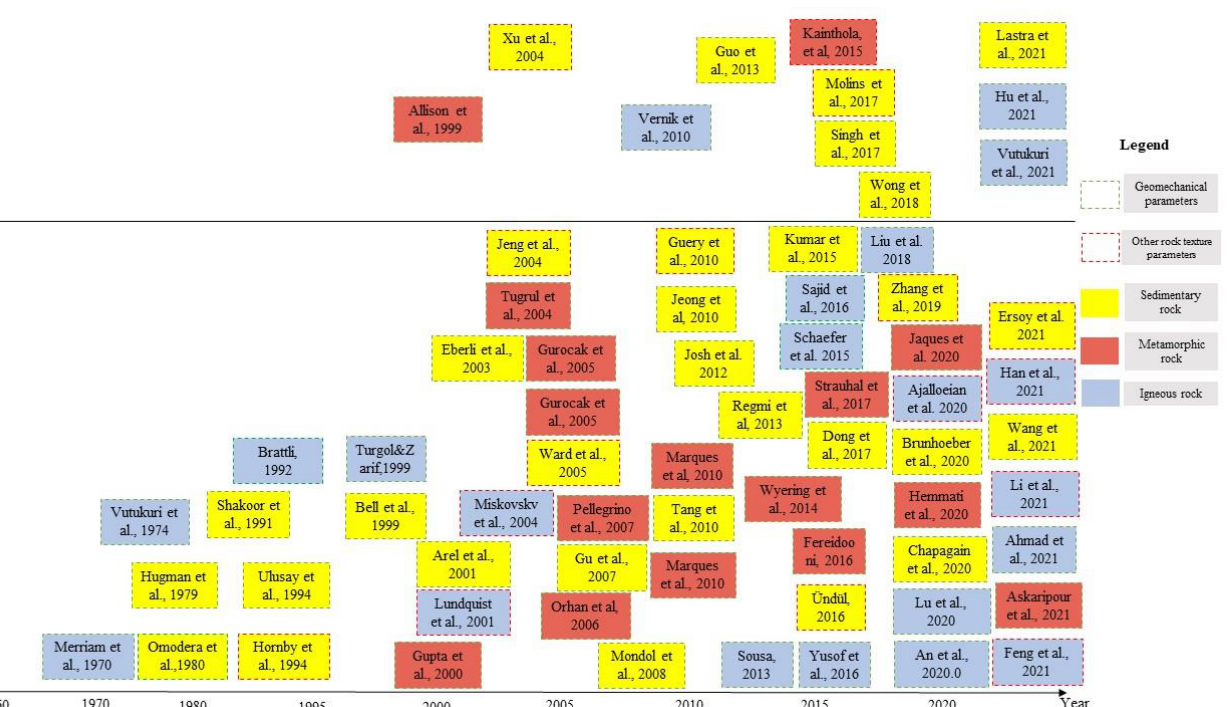
Table 10. Regression equations between mechanical properties and quartz-to-feldspar ratio (( σ c , I s50 , and σ t are in Mpa).